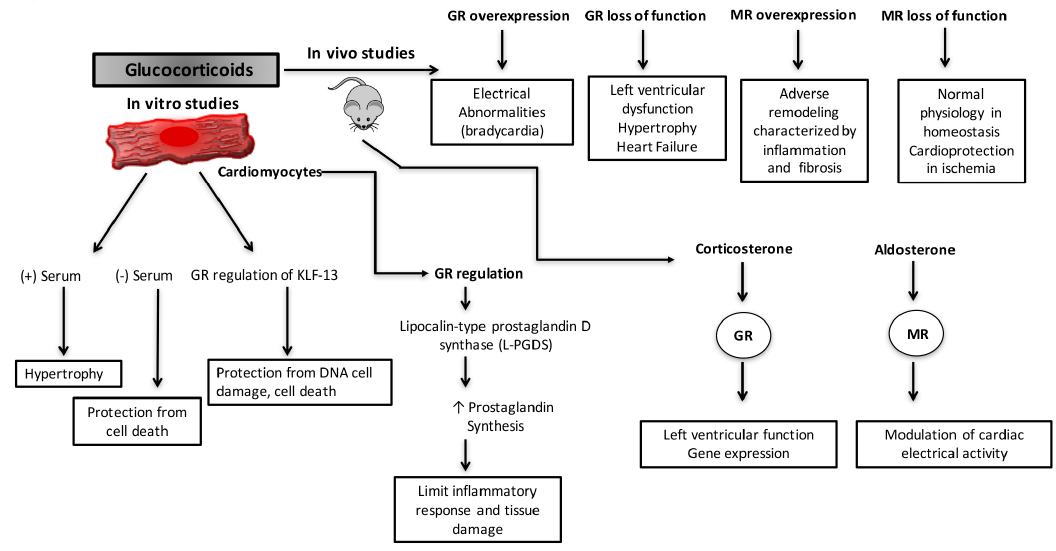
Figure 3. The physiological effects of glucocorticoids in the heart. Glucocorticoid treatment of cardiomyocytes has both positive and negative effects (right panel). In the setting of ischemia/reperfusion glucocorticoid treatment protects the cells against apoptosis by regulating the